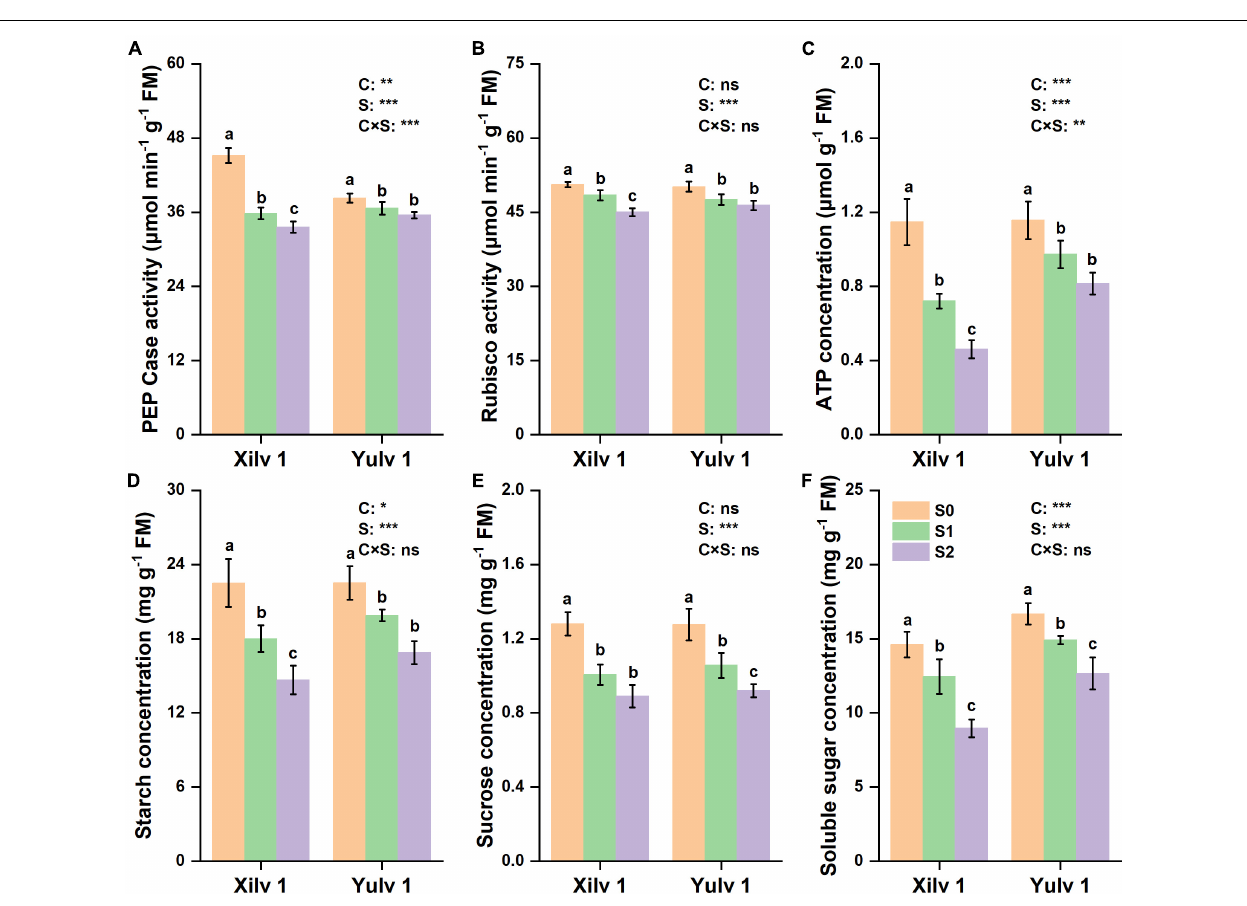
FIGURE 6 | Effect of shading stress on the leaf physiological parameters in mung bean. (A) Phosphoenolpyruvate carboxylase (PEP Case); (B) Rubisco; (C) ATP; (D) starch; (E) sucrose; and (F) soluble sugar. Values followed by a different letter are significantly different at p < 0.05. S0, no shading; S1, moderate shading; and S2, severe shading. *, **, and *** significant at the 0.05, 0.01, and 0.001 probability levels, respectively. ns, no significant difference.